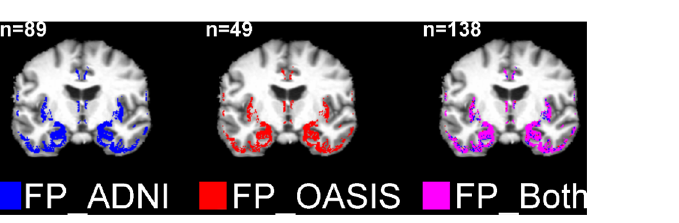
Fig 11. Locations of “ abnormal P , normal NP ” (FP) voxels in Alzheimer ’ s disease (AD) subjects (aged 60 – 90 years) from ANDI (n = 89) and OASIS (n = 49). These were determined via voxel classification with parametric (mean ± SD) and nonparametric (order-based) grey matter atlases; P = parametric; NP = nonparametric; ADNI = Alzheimer ’ s Disease Neuroimaging Initiative; OASIS = Open Access Series of Imaging Studies.